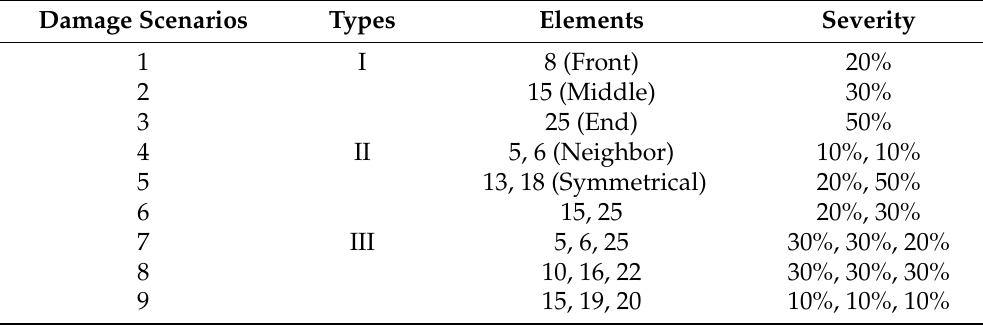
Table 2. Damage scenarios for the cantilever